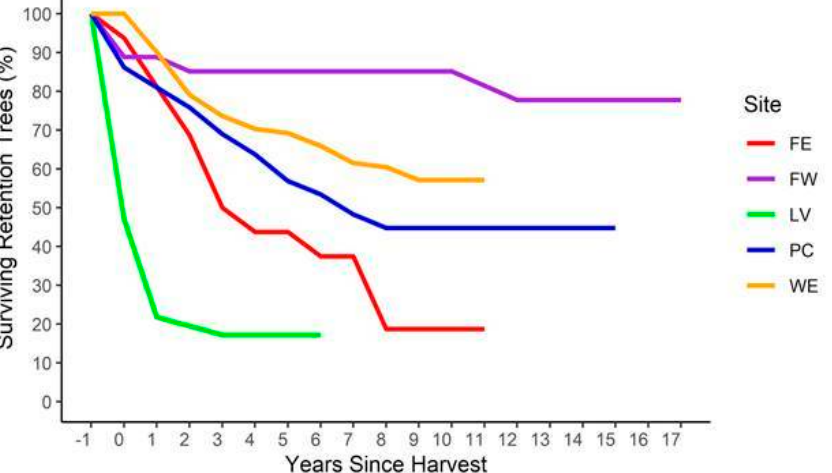
Figure 2. Post-harvest attrition of retained whitebark pine according to harvest site (FE: Findlay